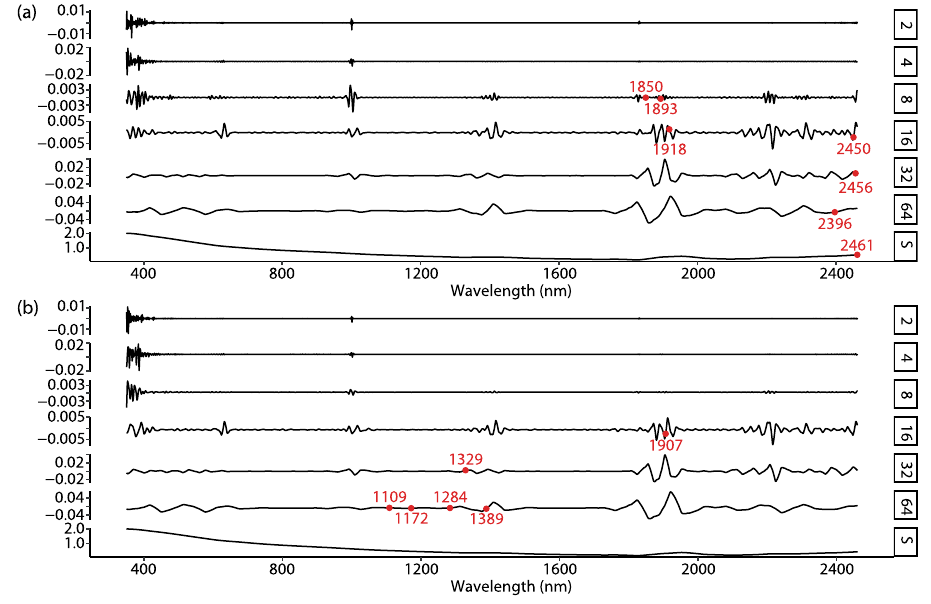
Figure 4. Optimal combinations of wavelets for explaining soil clay ( a ) and pH values ( b ).